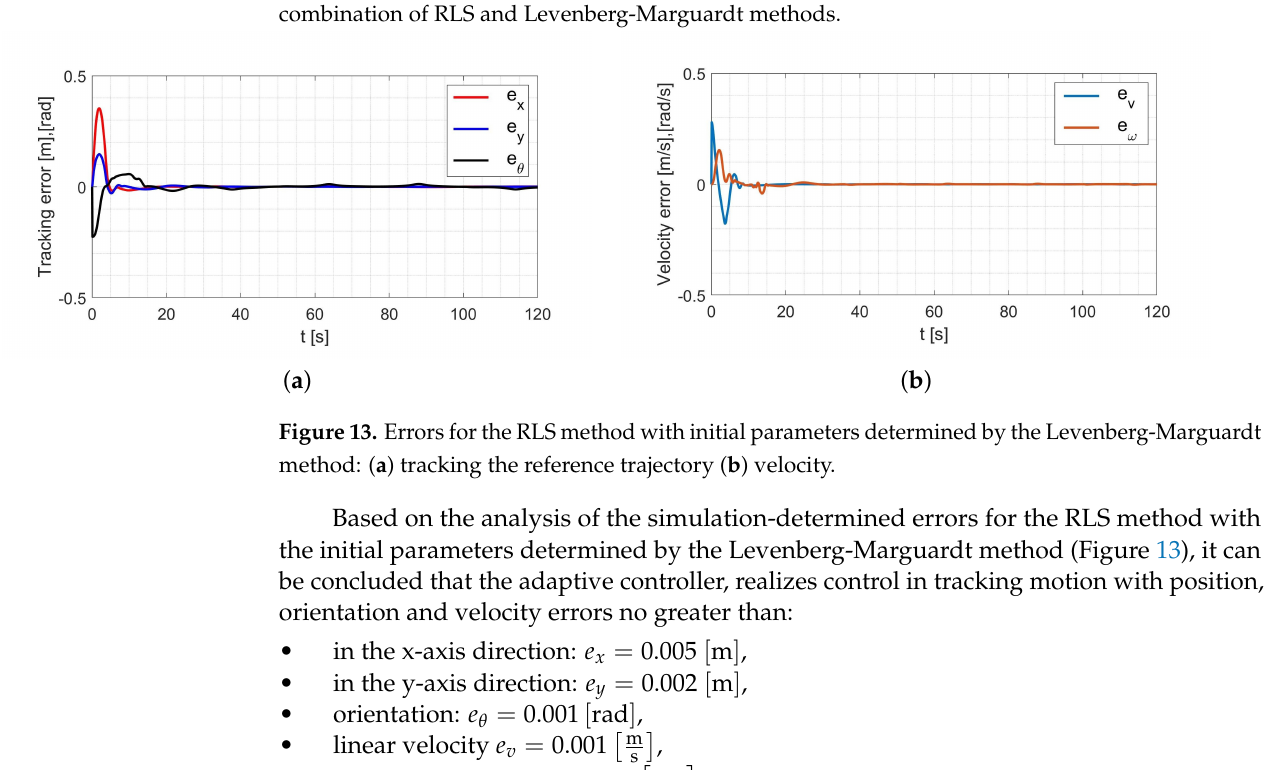
Figure 12. Comparison of the reference trajectory and the one obtained by simulation for the combination of RLS and Levenberg-Marguardt methods.